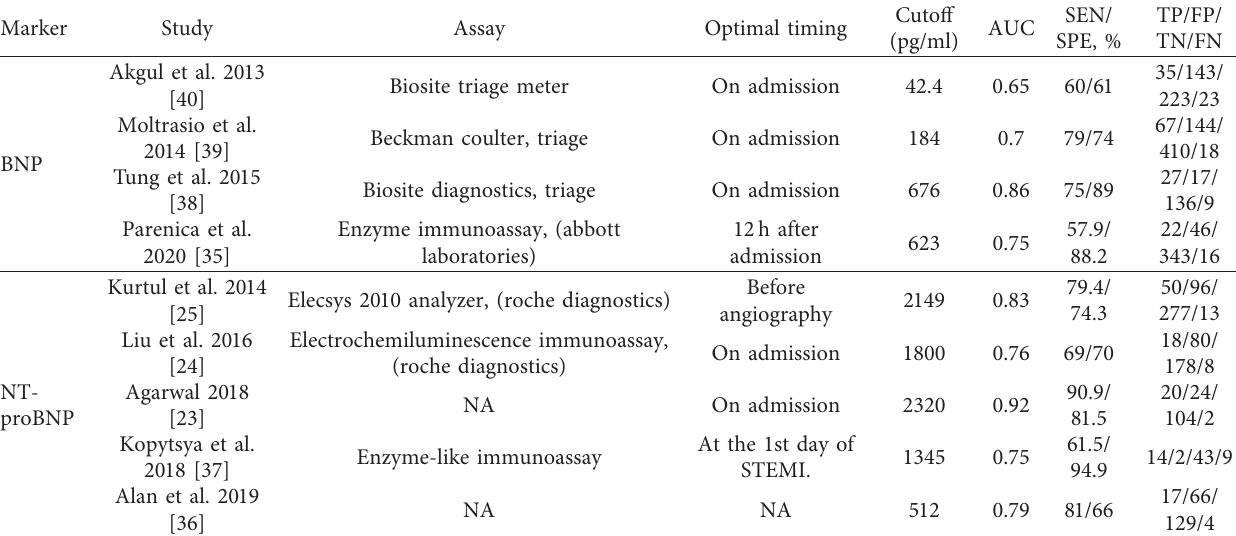
Table 2: BNP and NT-proBNP